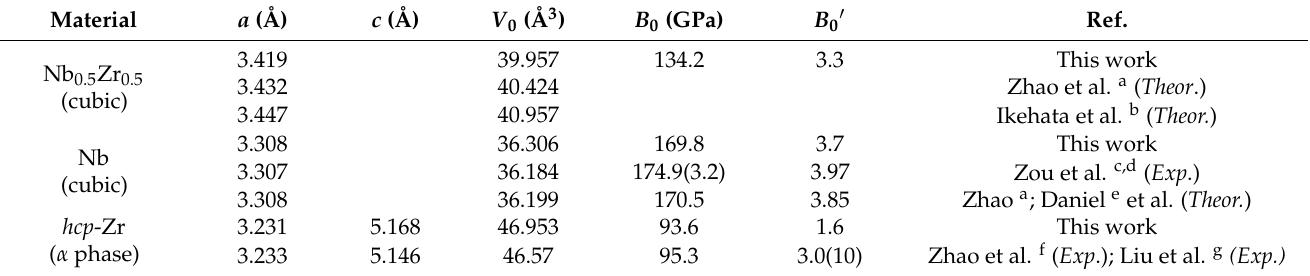
Table 1. Summary of lattice parameters ( a , c ), unit-cell volume ( V 0 ), bulk modulus ( B 0 ), and its pressure derivative ( B 0 (cid:48) ) at ambient